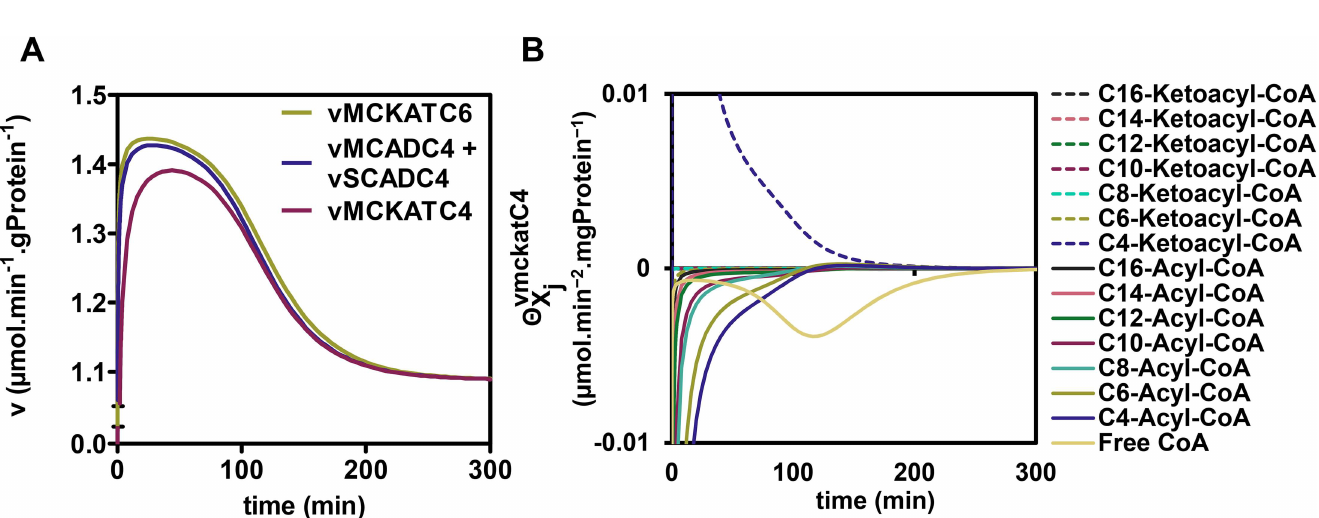
Fig 4. Time course of key short-chain reaction rates and regulation of the MCKAT-C4 reaction. (A) Time course of the reactionrates of MCKAT for its C6 and C4 substrates (vMCKATC6 and vMCKATC4, respectively) and of the summedactivities of SCAD and MCAD on their C4 substrate(vMCADC4+ vSCADC4) after a suddenupshift of [palmitoyl-CoA] CYT from 0.1 to 60 μ M. (B) Time course of regulatorymetabolitecontributions to vMCKATC4 after a sudden[palmitoyl-CoA] CYT increasefrom 0.1 to 60 μ